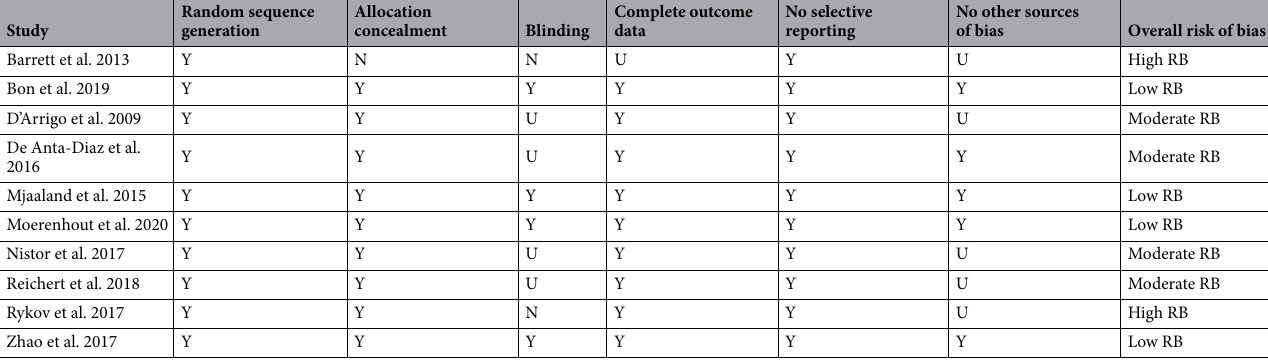
Table 2. Risk of bias assessment. DAA direct anterior approach, Y Yes, U Unclear, N No, RB risk of